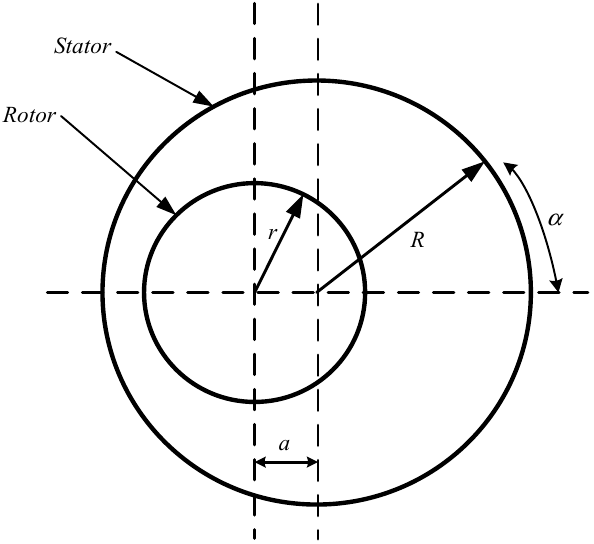
Figure 2. Modeling of the induction motor using FEM.